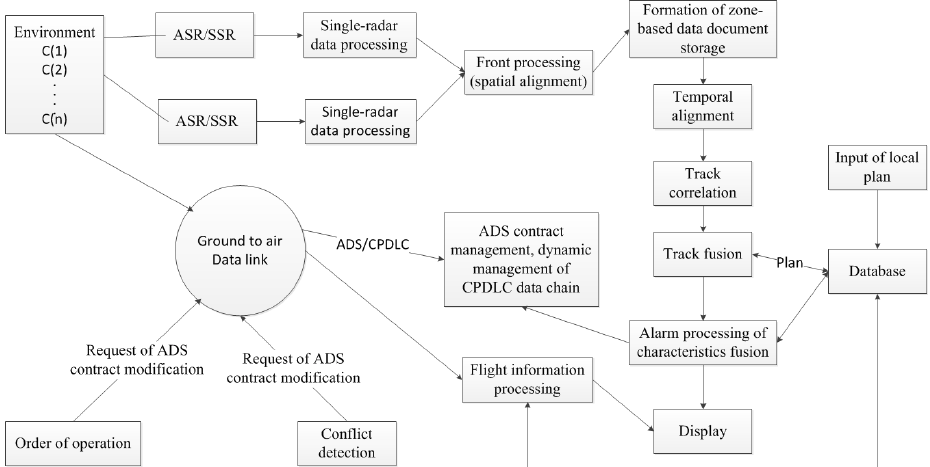
Figure 2. Logic structure of multi-radar and Automatic Dependent Surveillance (ADS) data fusion.